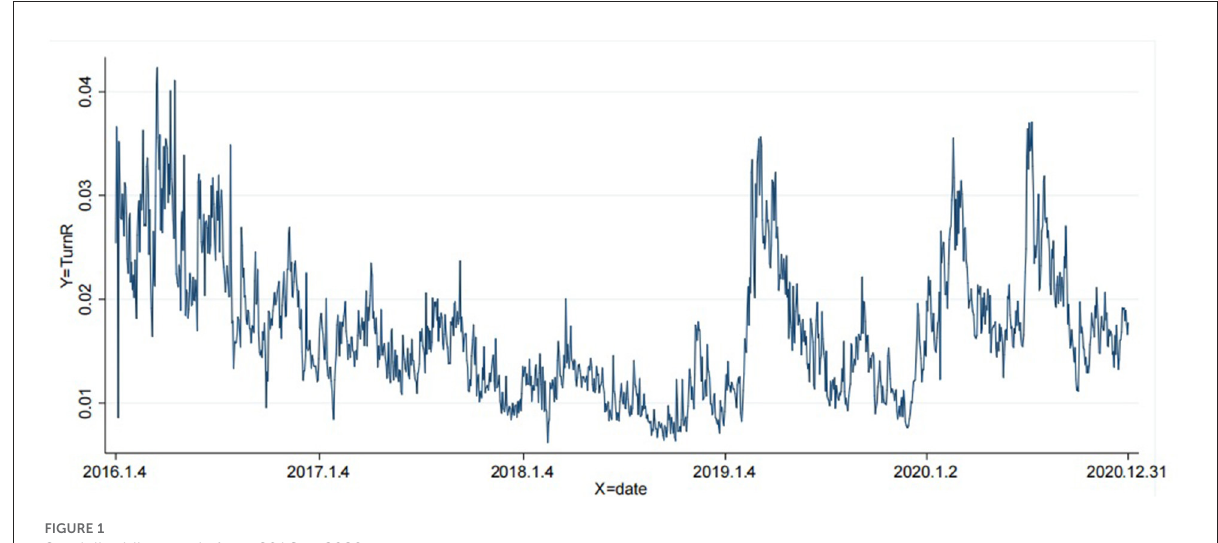
FIGURE1 Stock liquidity trends from 2016 to